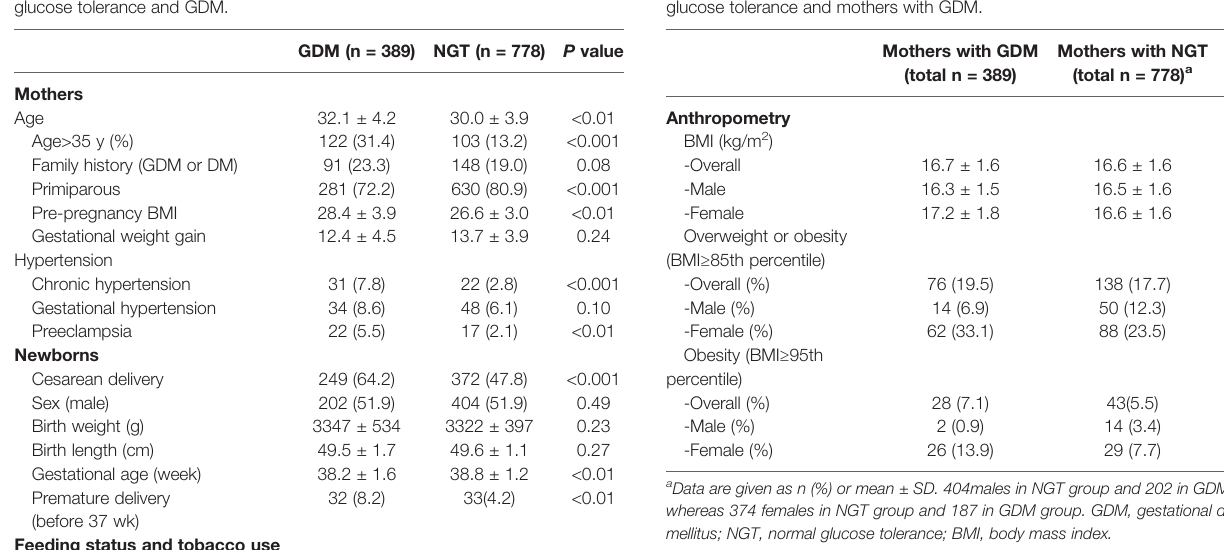
Table 3 depicts the unadjusted and adjusted odds ratios for obesity or overweight in 1-year old offspring strati fi ed by maternal GDM. Maternal GDM was found to be signi fi cantly associated with female offspring overweight or obesity (OR